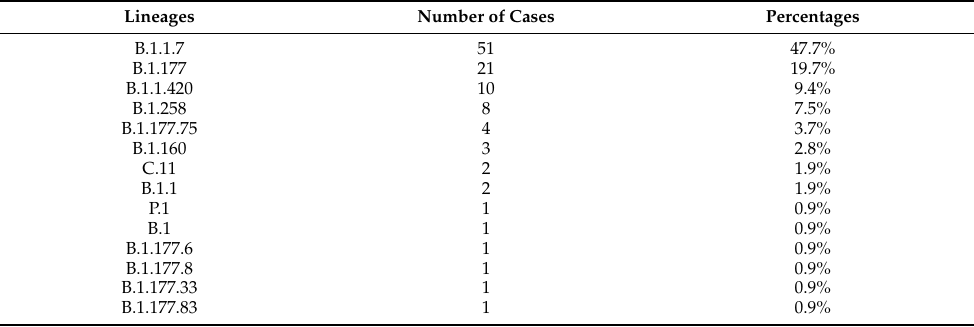
Figure 4. Three typical amplification results of Variants qRT-PCR. ( a ) The presence of only one green amplification curve indicates that wild type (WT) sequences of SARS-CoV-2 have been amplified. ( b ) Purple, red, and green curves occurring simultaneously (69-70del, N501Y mutated and E484K WT, respectively) determine for the B.1.1.7 variant. ( c ) Blue, red and green curves (E484K mutated, N501Y mutated and 69-70del WT, respectively) detect the B.1.351 or P.1 variant. Table 1. Lineages identified and relative number of cases and percentage from December 2020 to April